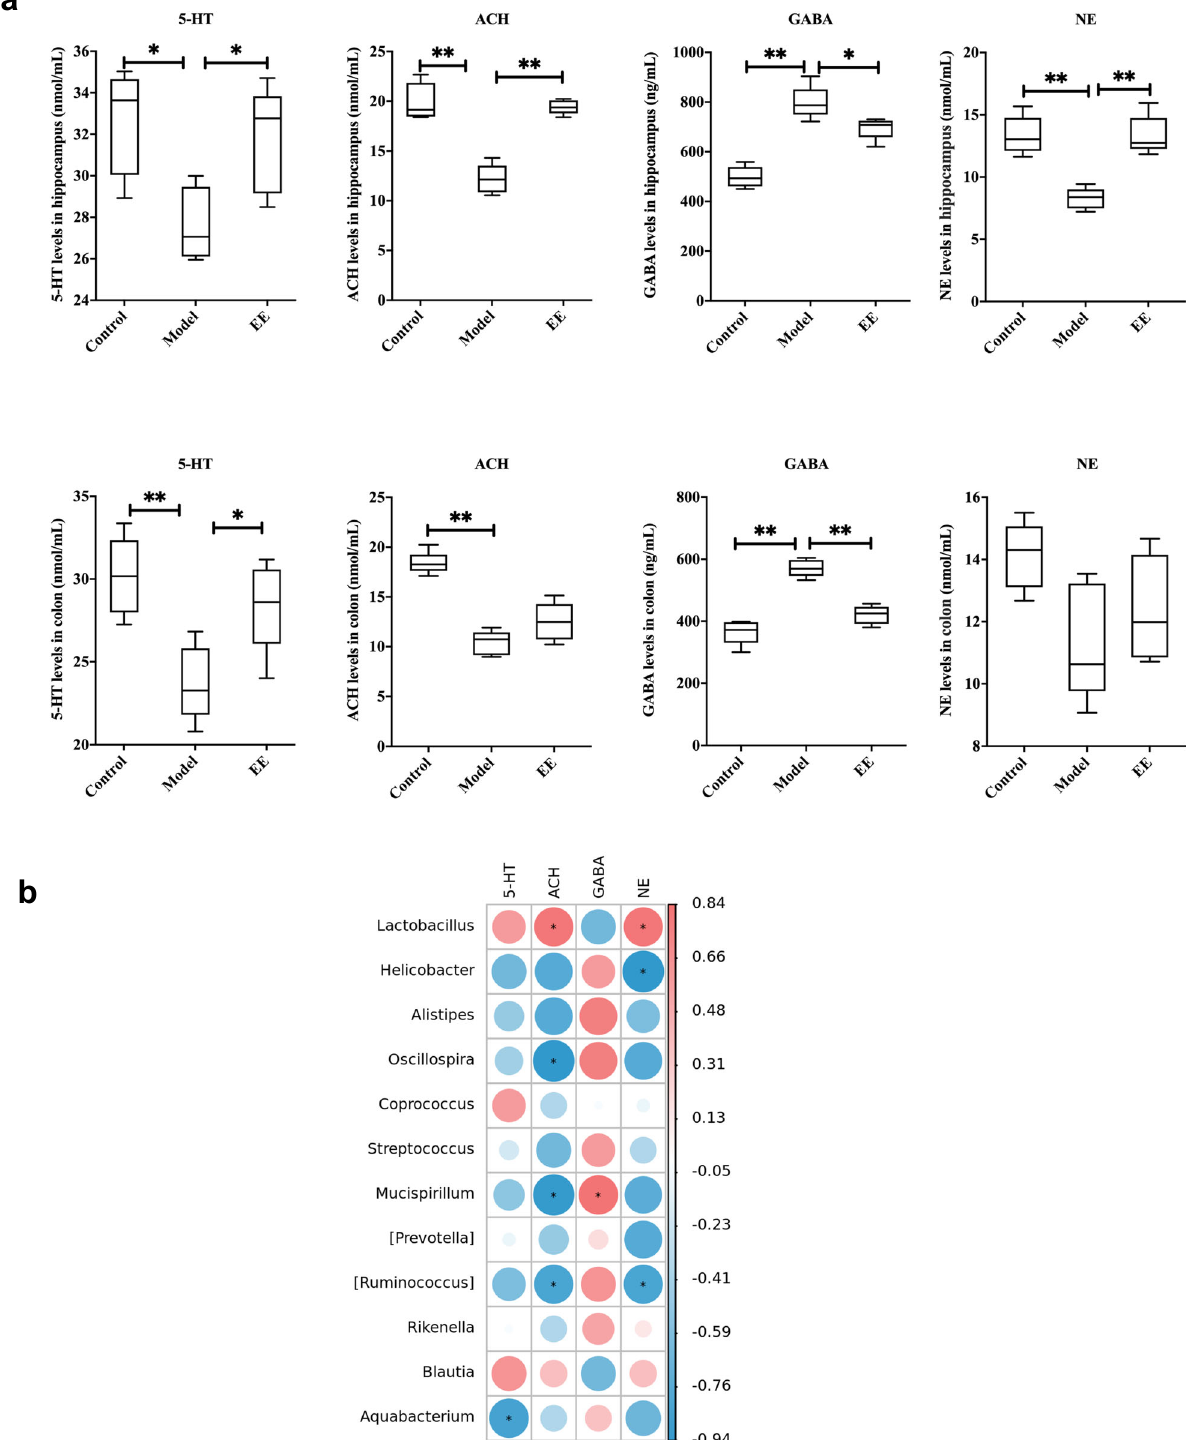
Fig. 5 EE intake alters neurotransmitter levels and their associated microbiome. a The levels of neurotransmitters in hippocampus and colon. Values are expressed as the mean ± SD ( n = 5). Statistical analyses were conducted using the one-way ANOVA followed by Tukey ’ s post hoc test, * p < 0.05, ** p < 0.01. b Correlation analysis among neurotransmitters in hippocampus and gut microbiota. Spearman ’ s correlation analysis was performed by data of the Model group and EE